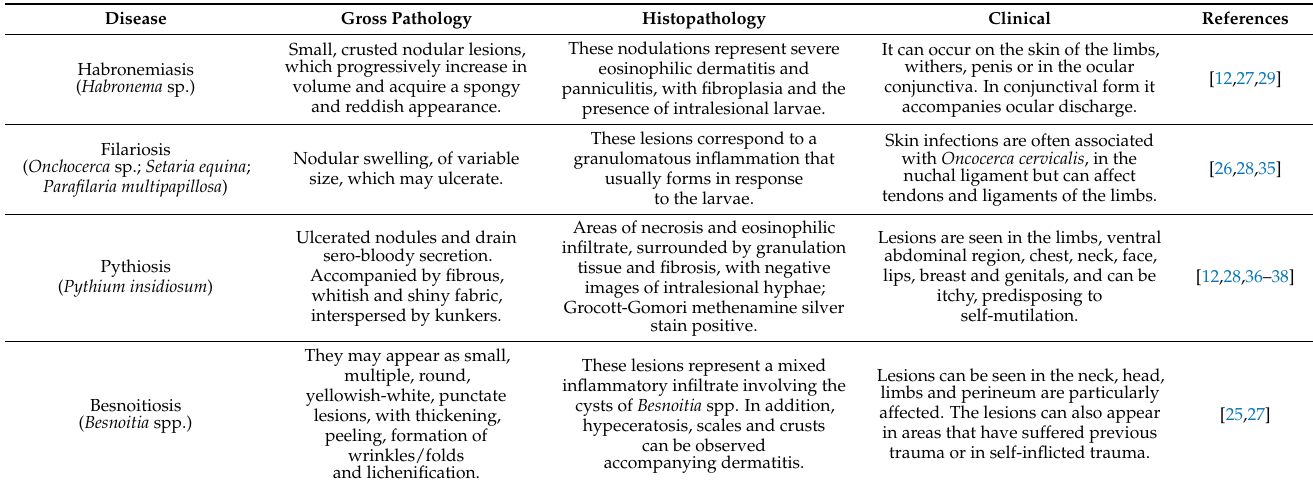
Table 2. Clinical and pathological characteristics of skin diseases caused by parasites and oomycetes in donkeys and mules.